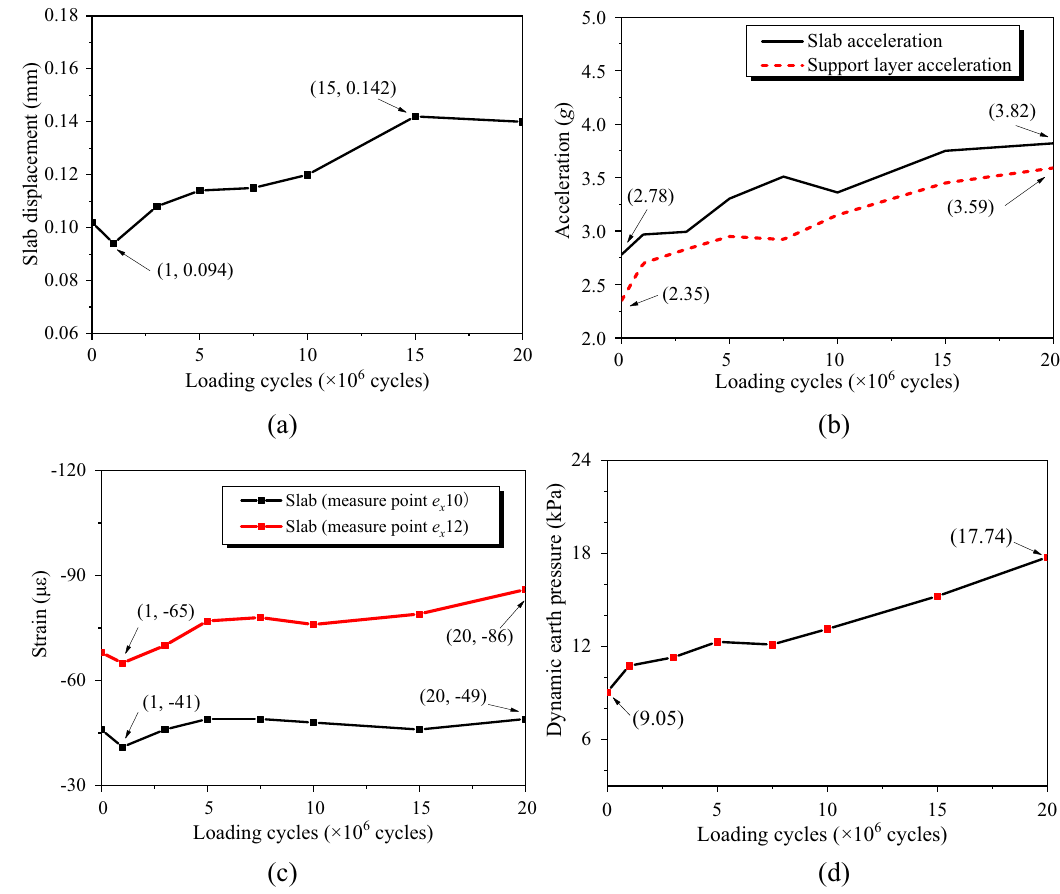
Fig. 20 Dynamic performance evolution of the track structure under 20 million cyclic loads: a dynamic displacement of track slab, b accelerations of slab and supporting layer, c longitudinal dynamic strain of slab; d dynamic earth pressure of